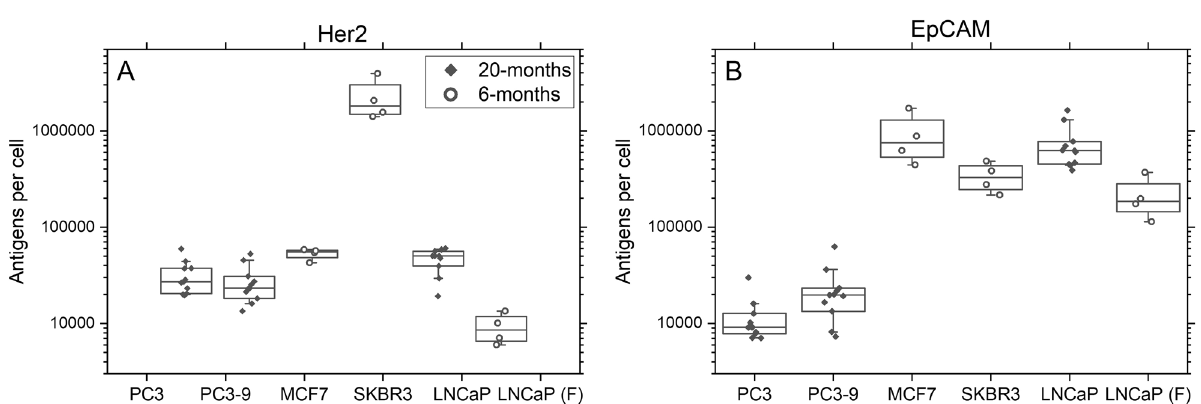
Figure 2. Expression of ( A ) Her2 and ( B ) EpCAM in unfixed PC3, PC3-9, MCF7, SKBR3, LNCaP as well as formaldehyde fixed LNCaP measured over a 6 or 20-month period. Boxes indicate 25–75 percentile with the median as a horizontal line, whiskers indicate 10–90